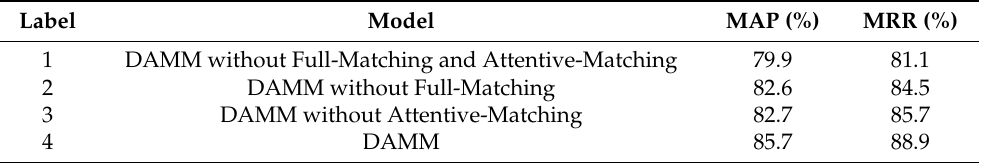
Table 8. Effect of different models on rice-related answer selection